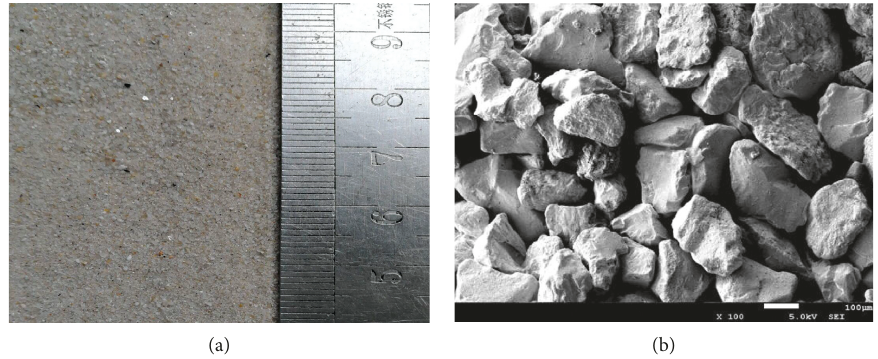
Figure 6: Sand used in the test (reproduced from Tan et al. [4]). (a) Camera figure. (b) SEM figure.